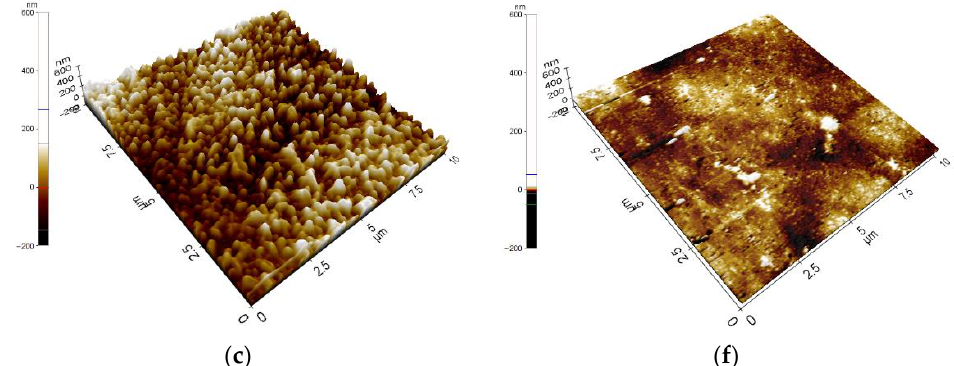
Figure 2. Structure and surface morphology of the thin film composite membrane (TFC) and cellulose triacetate membrane (CTA-W(P)). ( a ) Field-emission scanning electron microscopy (FESEM) micrograph of TFC cross-section at 500×. ( b ) FESEM micrograph of the surface of TFC active layer at 100,000×. ( c ) Atomic force microscopy (AFM) image of the surface of TFC active layer. ( d ) FESEM micrograph of CTA-W(P) cross-section at 500×. ( e ) FESEM micrograph of the surface of CTA-W(P) active layer at 100,000×. ( f ) AFM image of the surface of CTA-W(P) active layer.